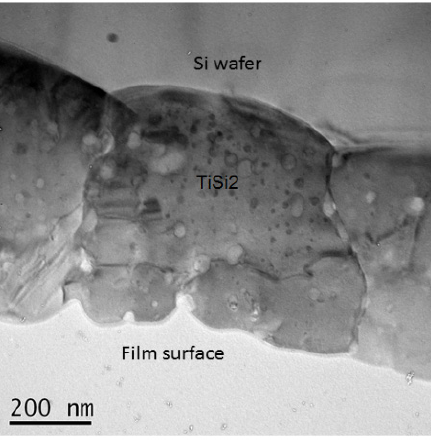
Figure 10. TEM cross ‐ section micrograph of TiSi 2 formed from Ti films, 500 nm thick, heated at 800 °C and processed in (Ar ‐ N 2 ‐ H 2 ) plasma for 1 h.